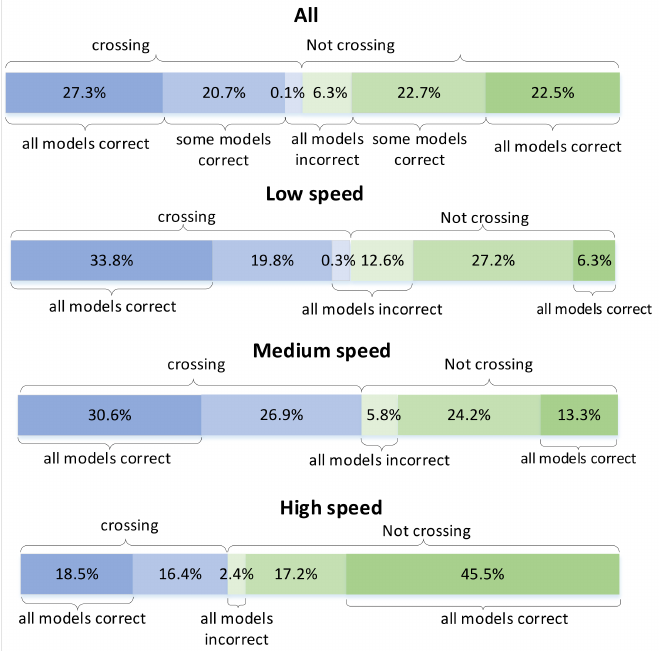
Figure 12. Proportion of crossing and not crossing samples in low-speed, medium-speed and high- speed pedestrians that are correctly classified by all/some/none